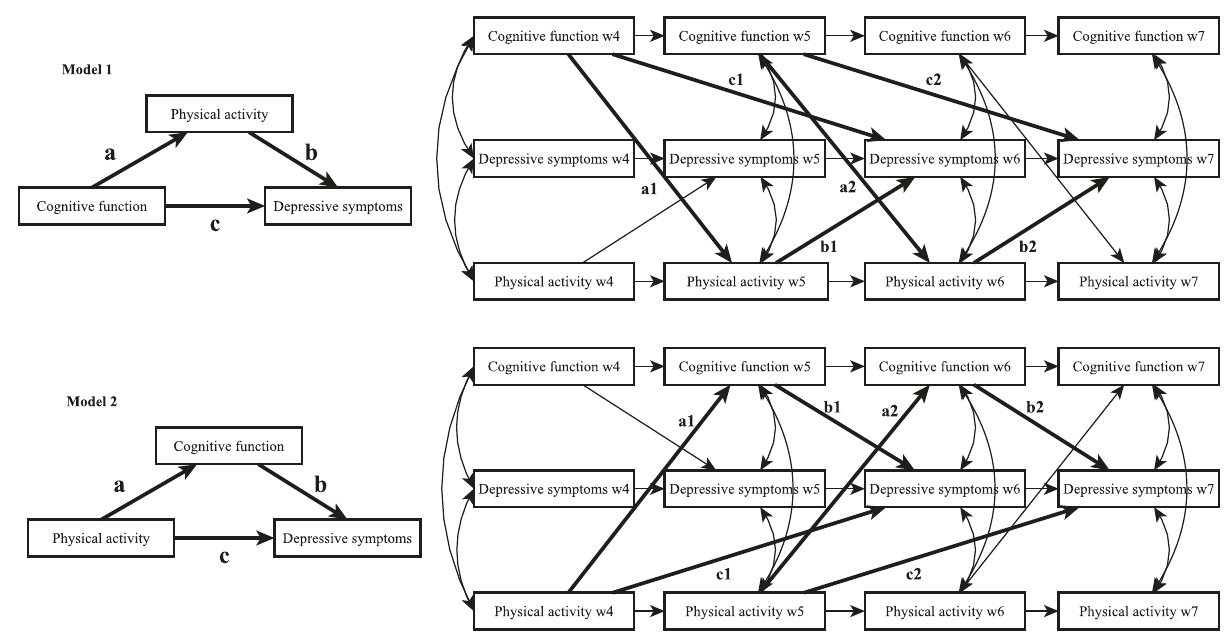
Fig. 1 Hypothesized autoregressive longitudinal mediation models. Top panel: Model 1 testing the mediating role of physical activity in the association between cognitive function and depressive symptoms. Bottom panel: Model 2 testing the mediating role of cognitive function in the association between physical activity and depressive symptoms.